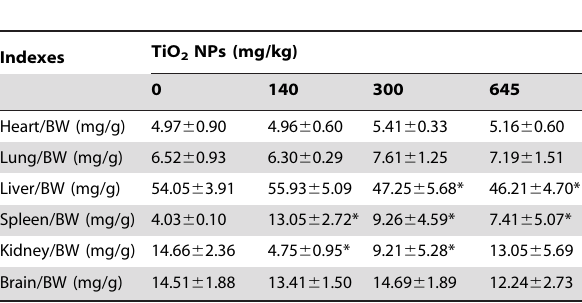
Table 2. Organ weight/BW coefficients (Mean 6